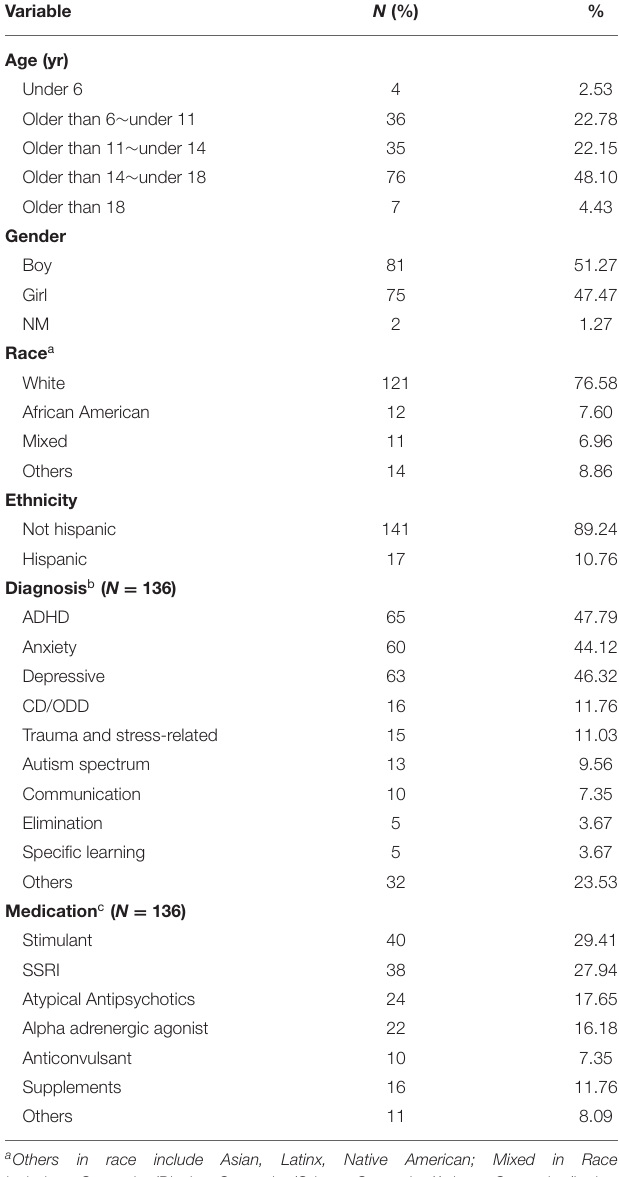
TABLE 1 | Descriptive statistics on the socio-demographic characteristics of the subjects ( N =